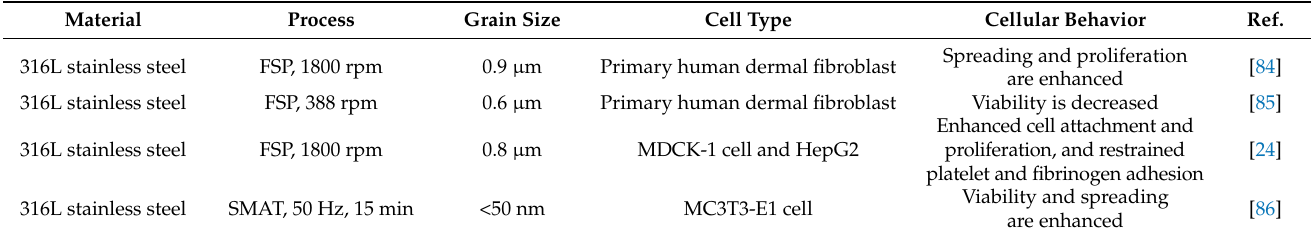
Table 3. Cell response to stainless steel after surface grain refinement.